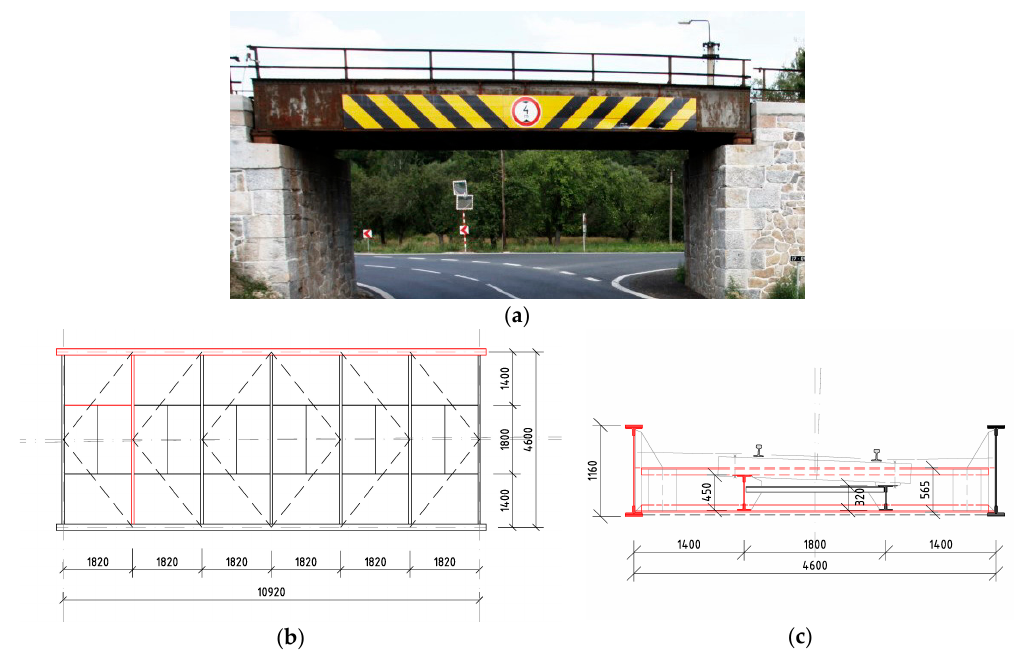
Figure 1. Bridge 1: the 142-year-old plate girder bridge with a bottom open member deck: ( a ) picture from the side; ( b ) schematic ground plan of the superstructure; ( c ) cross-section of the bridge; the chosen elements are drawn in red in ( b ) and ( c ).